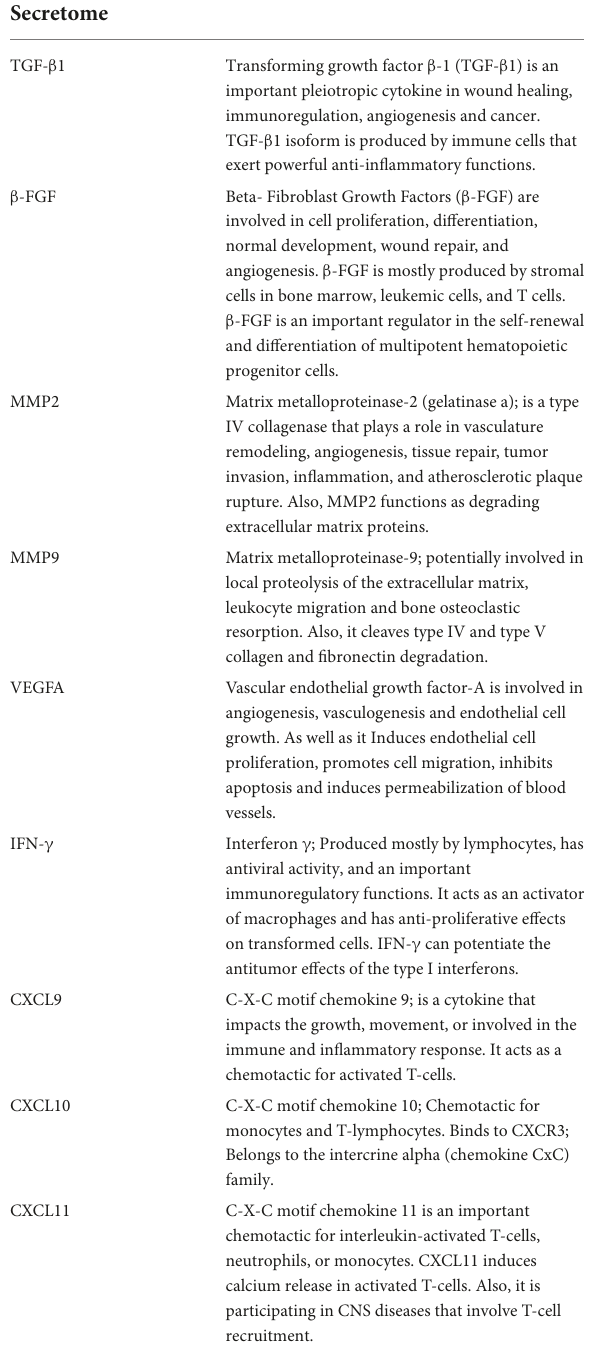
TABLE 1 Summarized list of the crucial autophagy-dependent secretome and inflammatory mediator in TME. Substances/ Secretome